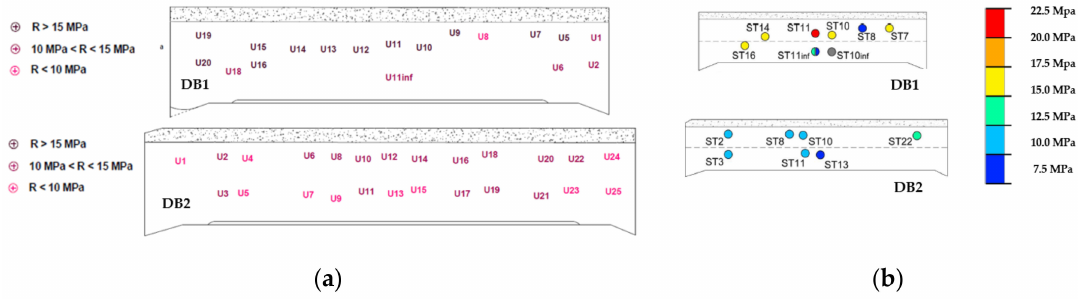
Figure 3. Beams DB1 and DB2: cubic concrete compressive strength values (R) along the beams obtained by ( a ) the corrected non-destructive tests at U test stations or ( b ) by destructive tests on concrete cores (ST). Table 1. Cubic concrete compressive strength (R) by compressive tests on cores (ST) and steel